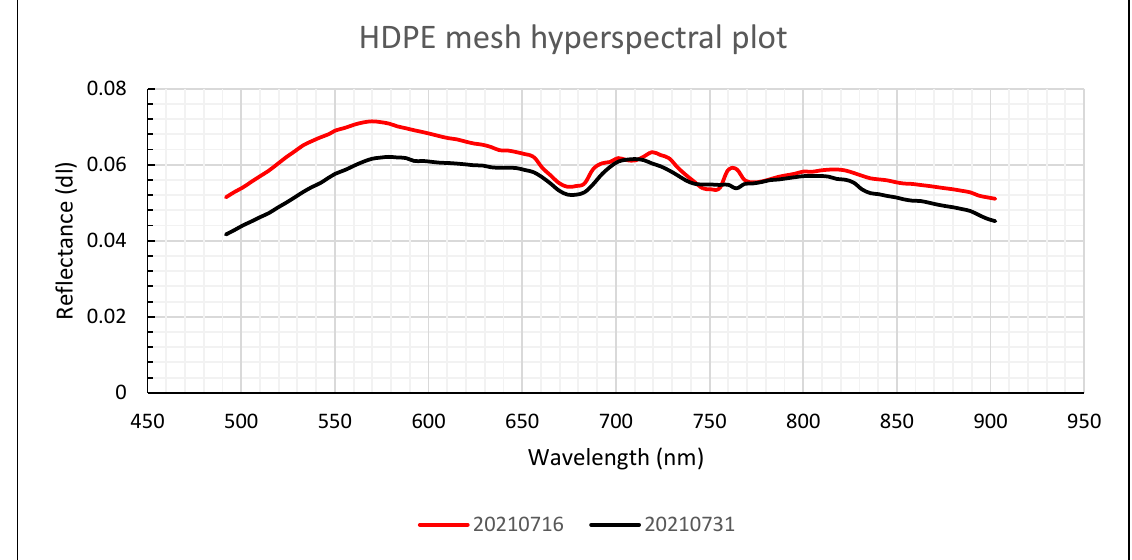
Figure A1. Hyperspectral plot of HDPE mesh target material with different levels of biofouling con- tamination.